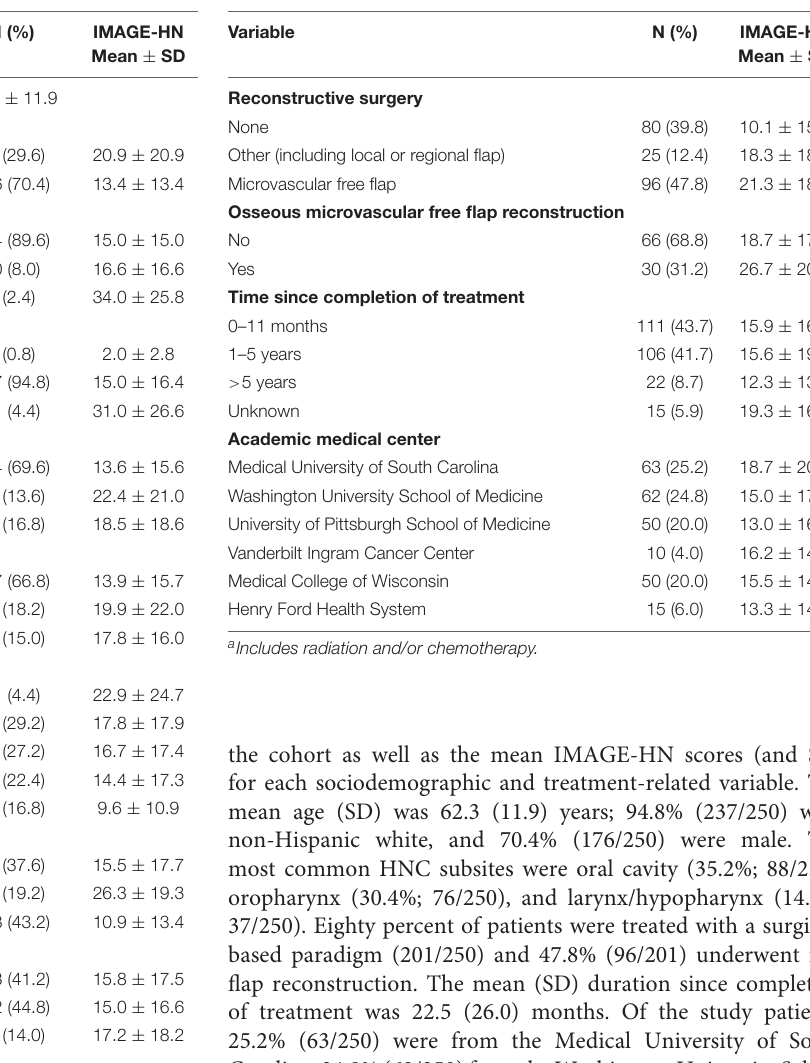
TABLE 1 | Participant